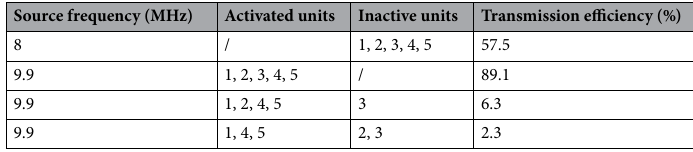
Table 1. Simulation results of transmission efficiency of 5 units in various states.